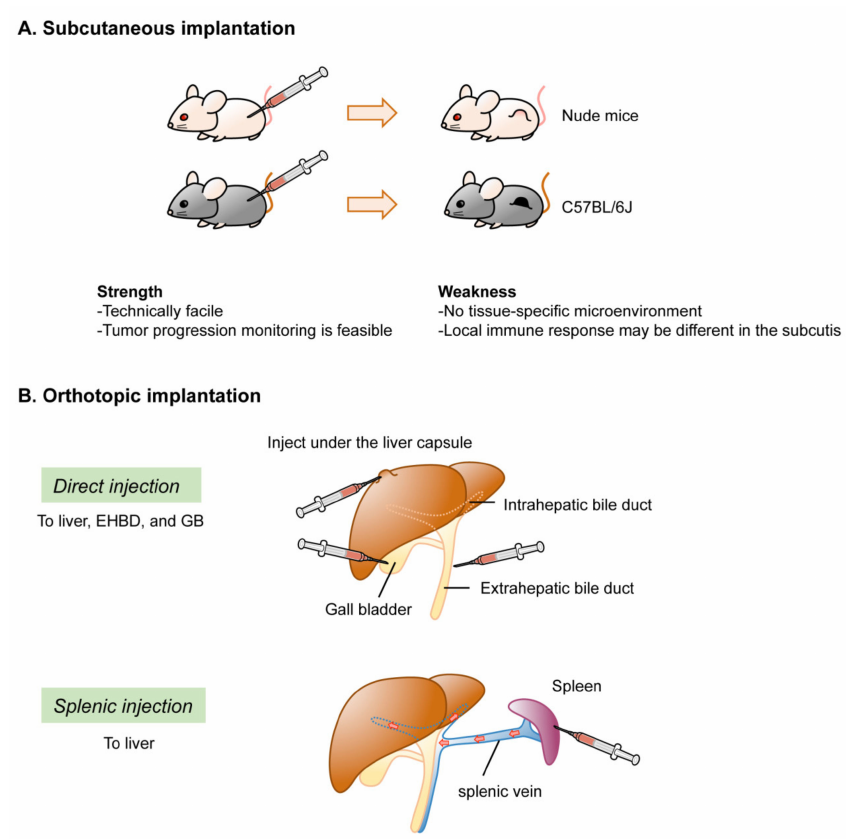
Figure 4. Implantation of organoids and derived tumor bud into mice. ( A ). Subcutaneous implanta- tion. For C57BL/6J, shaving hair is not mandatory on injection, but strongly recommended upon sacrifice. ( B ). Orthotopic implantation. Only one-step injection is illustrated. Note that direct injection to EHBD might be technically feasible, but has never been reported. Splenic injection can transfer cells to the liver via splenic vein and the portal